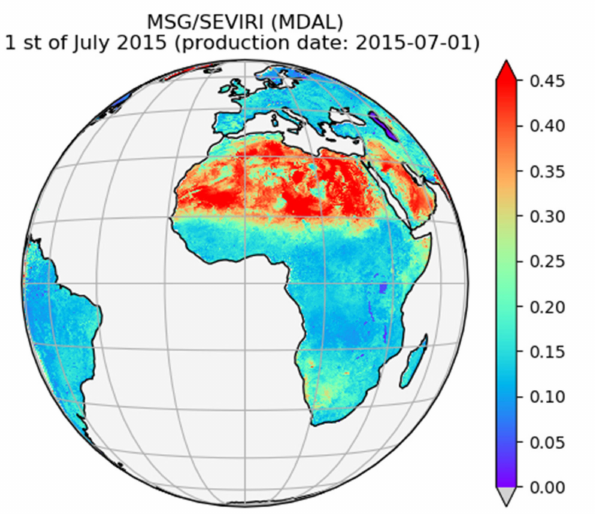
Figure 9. Total shortwave directional-hemispherical albedo (BB-DH) for 1 July 2015 based on MSG/SEVIRI